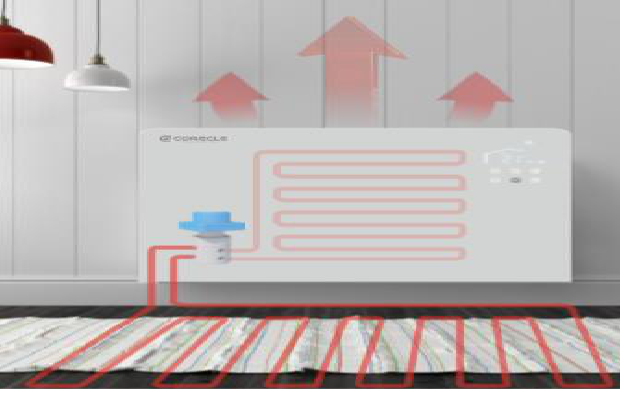
Figure 1. Floor radiation-convection combined heating system.